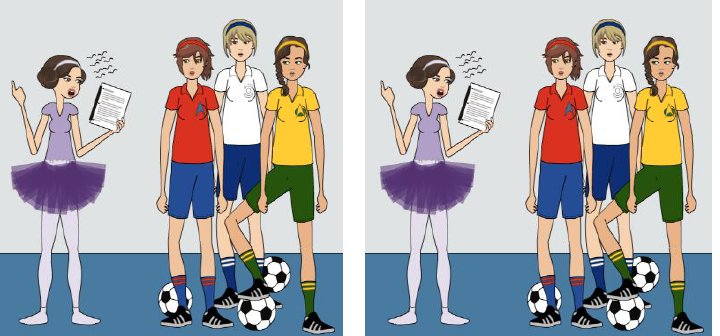
Source: Image created by author using Pixton